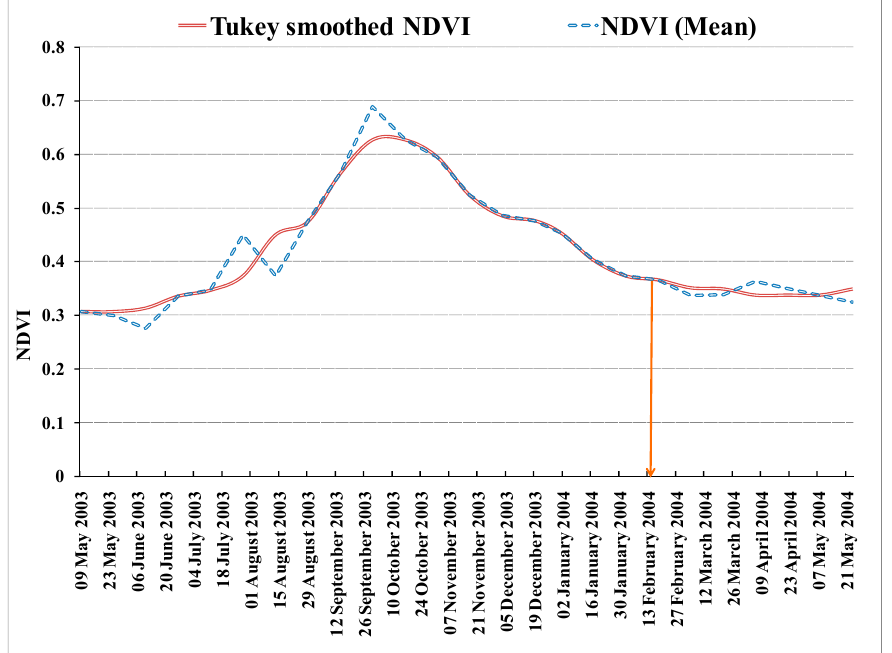
Figure 8. Raw MODIS NDVI and TS-smoothed reconstructed NDVI time series of year 2003–2004 for derivation of end of the season in Tectona grandis indicated by orange arrow.